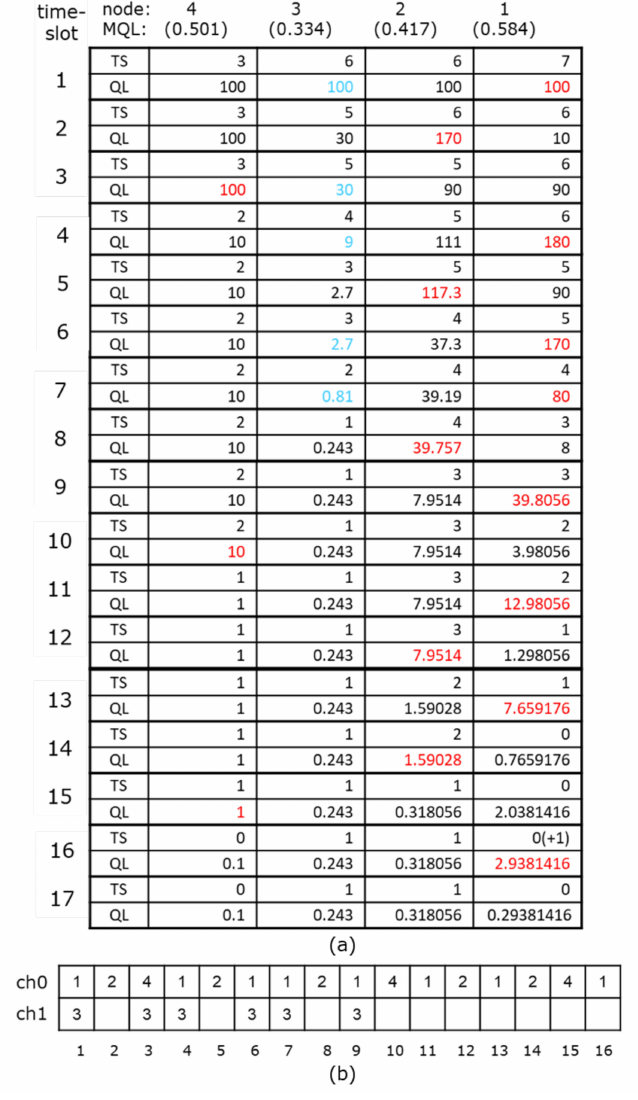
Figure 3. Scheduling steps ( a ) and the assignment result ( b ) for the sample graph in Figure 1 with